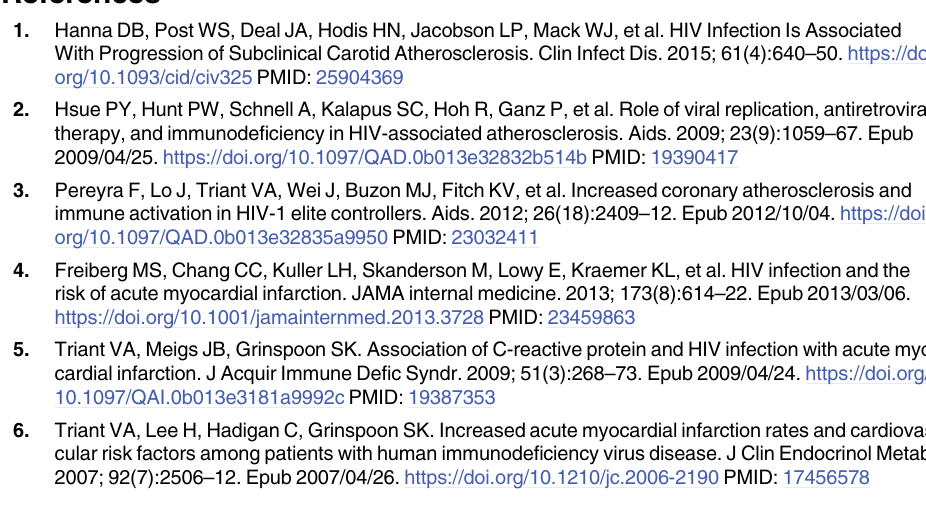
S9 Table. Associations between inflammatory biomarkers and intima media thickness at the right common carotid artery (N = 728). S10 Table. Associations between the fifth quintile of the inflammatory biomarkers and intima media thickness at the right common carotid artery, by HIV serostatus (n = 728). S11 Table. Associations between inflammatory biomarkers and IMT at the bifurcation of the right common carotid artery (N = 672). S12 Table. Associations between the fifth quintile of the inflammatory biomarkers and intima media thickness at the bifurcation of the right common carotid artery, by HIV ser- ostatus (n =